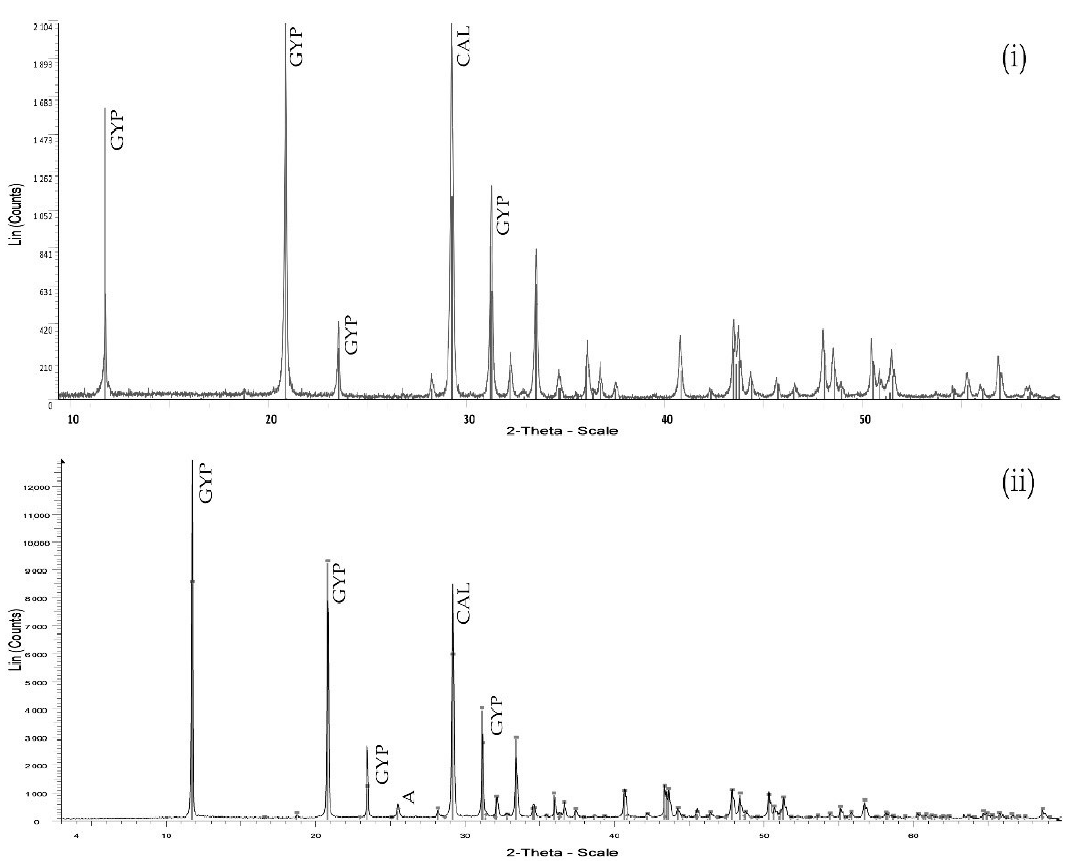
Figure 3. Diffractogram of samples ( i ) and ( ii ): gypsum (GYP); calcite (CAL); quartz (QTZ); anhydrite (A).